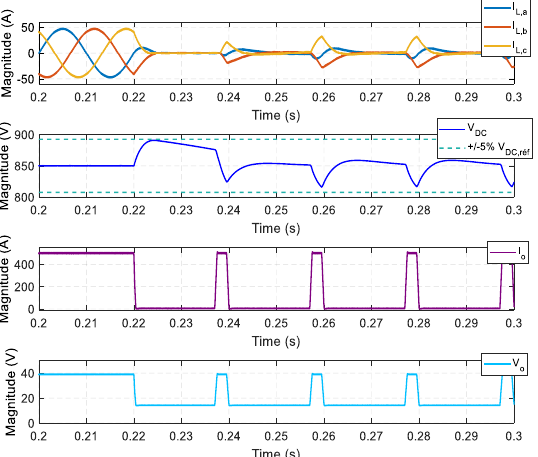
Figure 17. Waveforms in pulsed current operation mode.